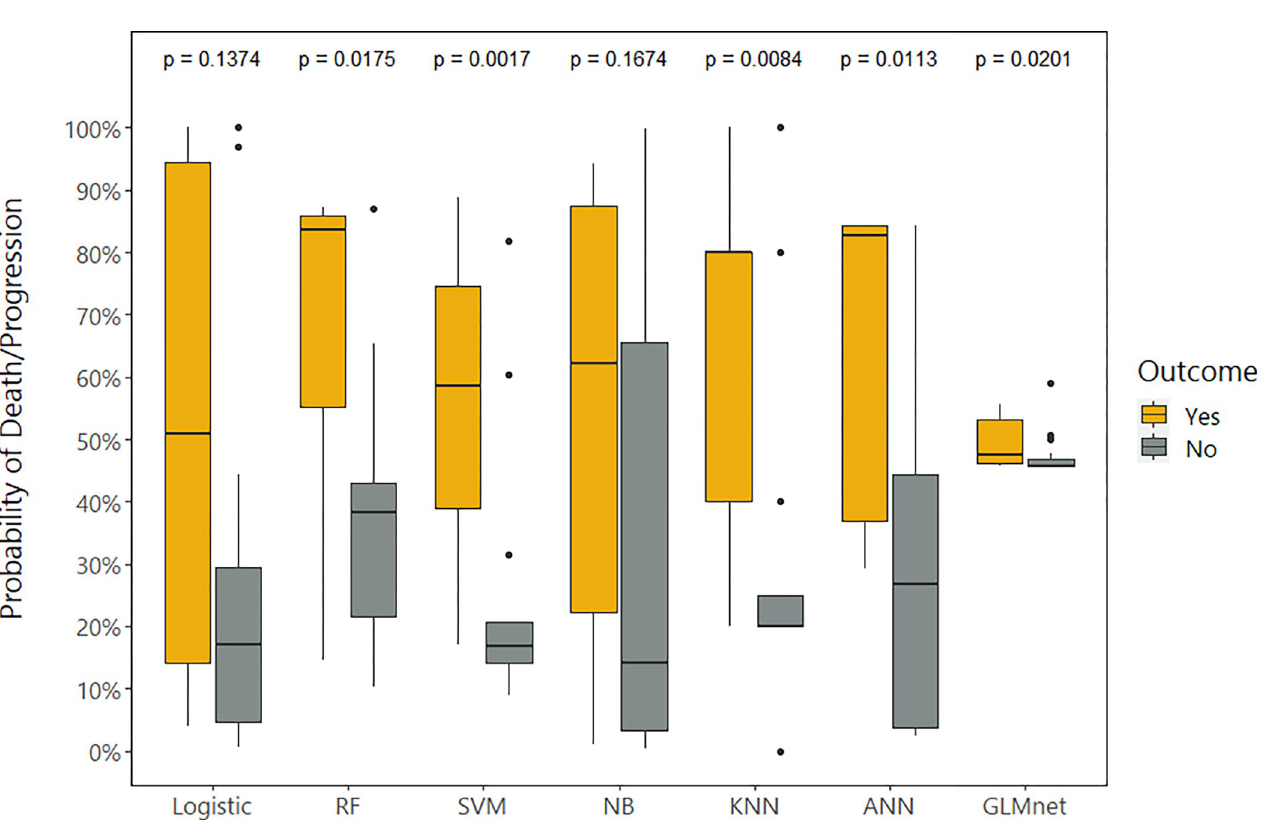
Fig 3. Probability of death/progression according to each algorithm in the validation